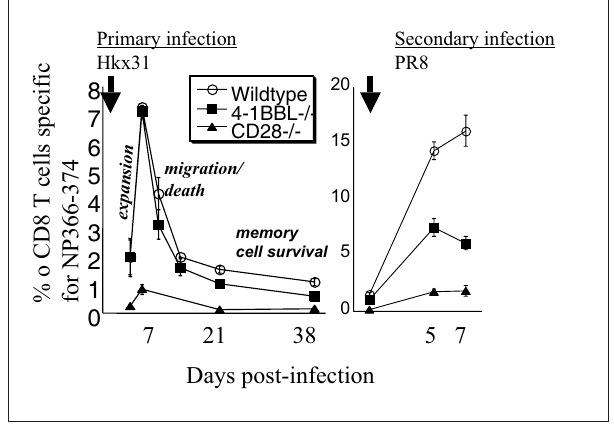
Figure 7) CD8+ T cell numbers in influenza infected wildtype (WT), CD28 knockout ( –/– ) or 4-1BBL –/– mice. Results are plotted as the percentage of CD8+ T cells in the spleen that bind MHC tetramers of D b /NP366-374. Note the Y-axis scale is different in the two panels. Mice lacking CD28 show very poor initial expansion of influenza spe- cific T cells following infection, whereas 4-1BBL –/– mice show normal initial expansion and contraction of the response. In contrast, 4-1BBL –/– mice show secondary responses to influenza that are indis- tinguishable from the primary response, implying a defect in recall or memory responses. A different recombinant virus is used in primary versus secondary challenge in these experiments. The two viral strains, Influenza A HkX31 and Influenza A PR8 have the same nucleoprotein (NP) gene recognized by the CD8+ T cells but differ in the neuro- minidase and hemagluttinin genes against which the major neutralizing antibody response is directed. This avoids neutralizing antibodies, pre- venting viral entry into cells and complicating the interpretation of the CD8+ T cell response. Data from reference